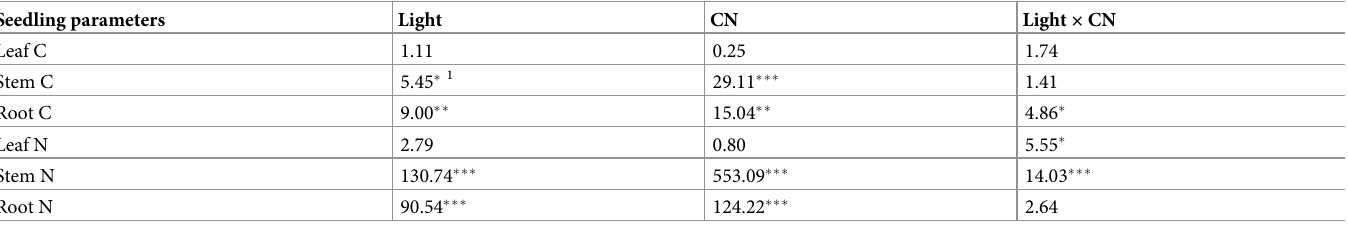
Table 3. F values from analysis of variance (ANOVA) of effects of light quality (Light), chitosan nanoparticle addition (CN), and their interaction (Light × CN) on nitrogen (N) and carbon (C) concentrations in Eleutherococcus senticosus seedlings. Seedling